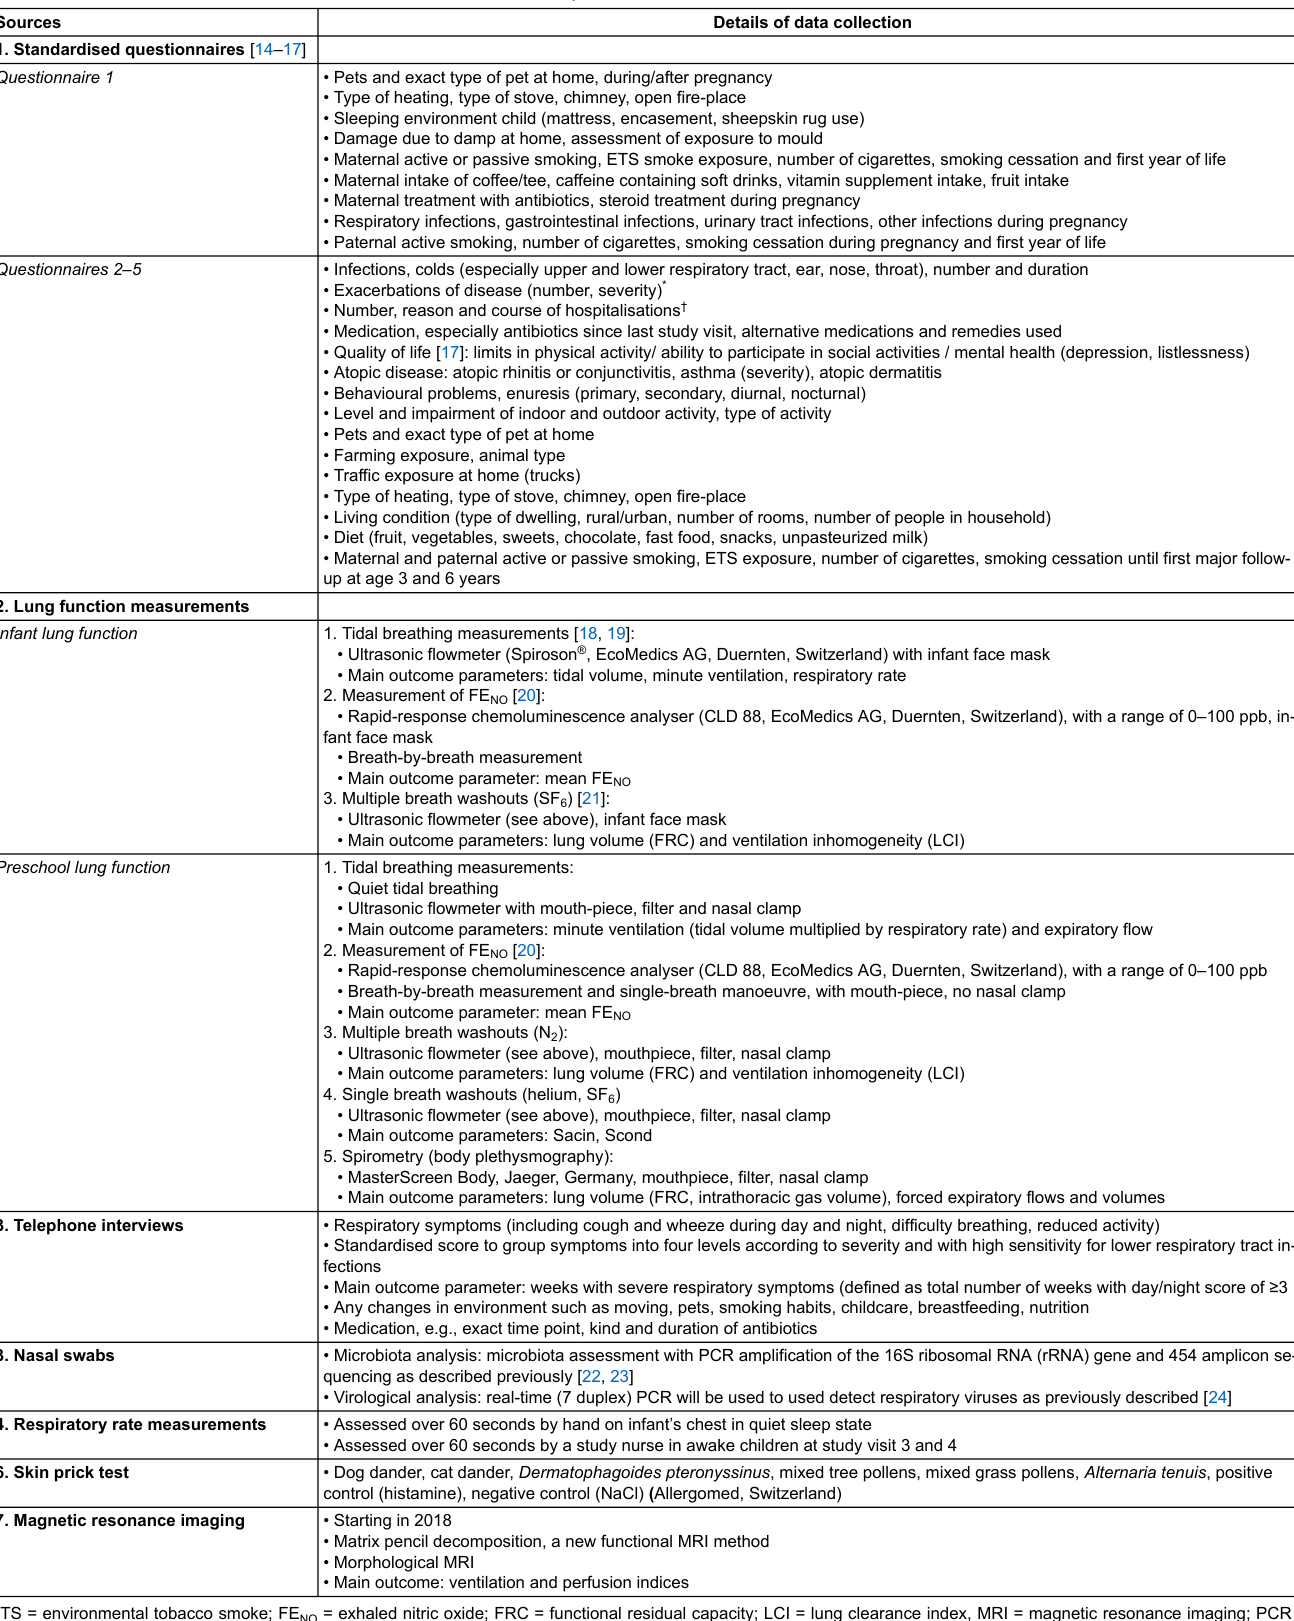
Table 1: Details of data collection from the different sources in the SCILD